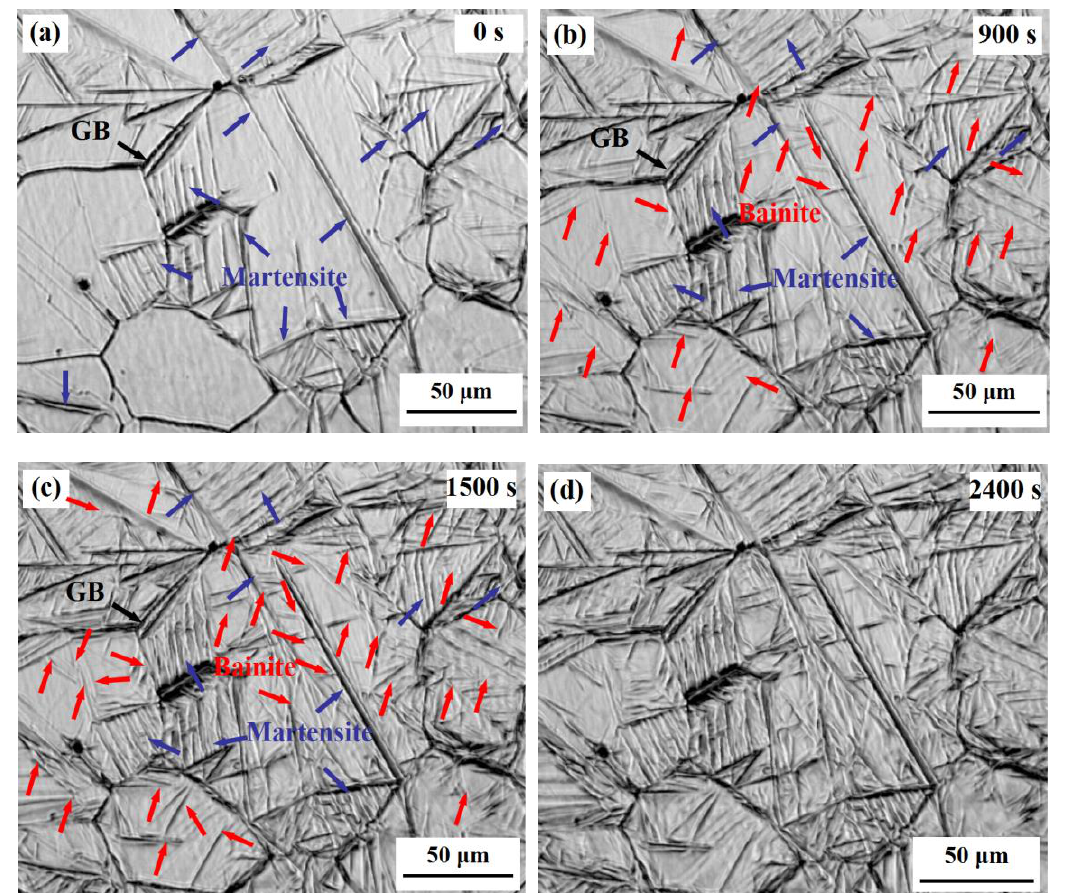
Figure 3. LSCM images of the QBT specimen with heating at 300 °C for several time lengths. ( a ) 0 s,